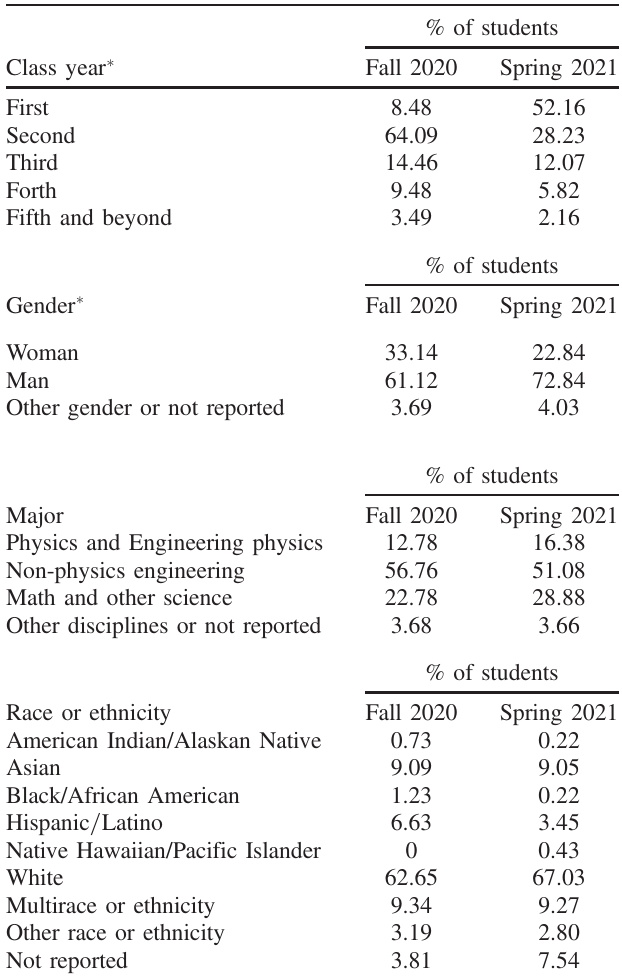
TABLE I. Self-reported demographic data of 407 students enrolled in the Fall 2020 semester and 464 students enrolled in the Spring 2021 semester of the CU Boulder PHYS-1140 Experimental Physics I course. Categories marked with an asterisk indicate that there are significant differences between the student populations in the two semesters as determined by a Mann-Whitney U test with p < 0 . 05